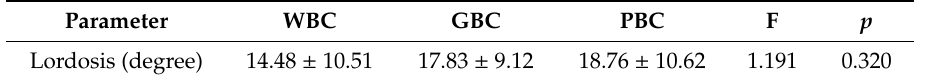
Table 1. Comparison of cervical alignment according to backpack carriage and type.